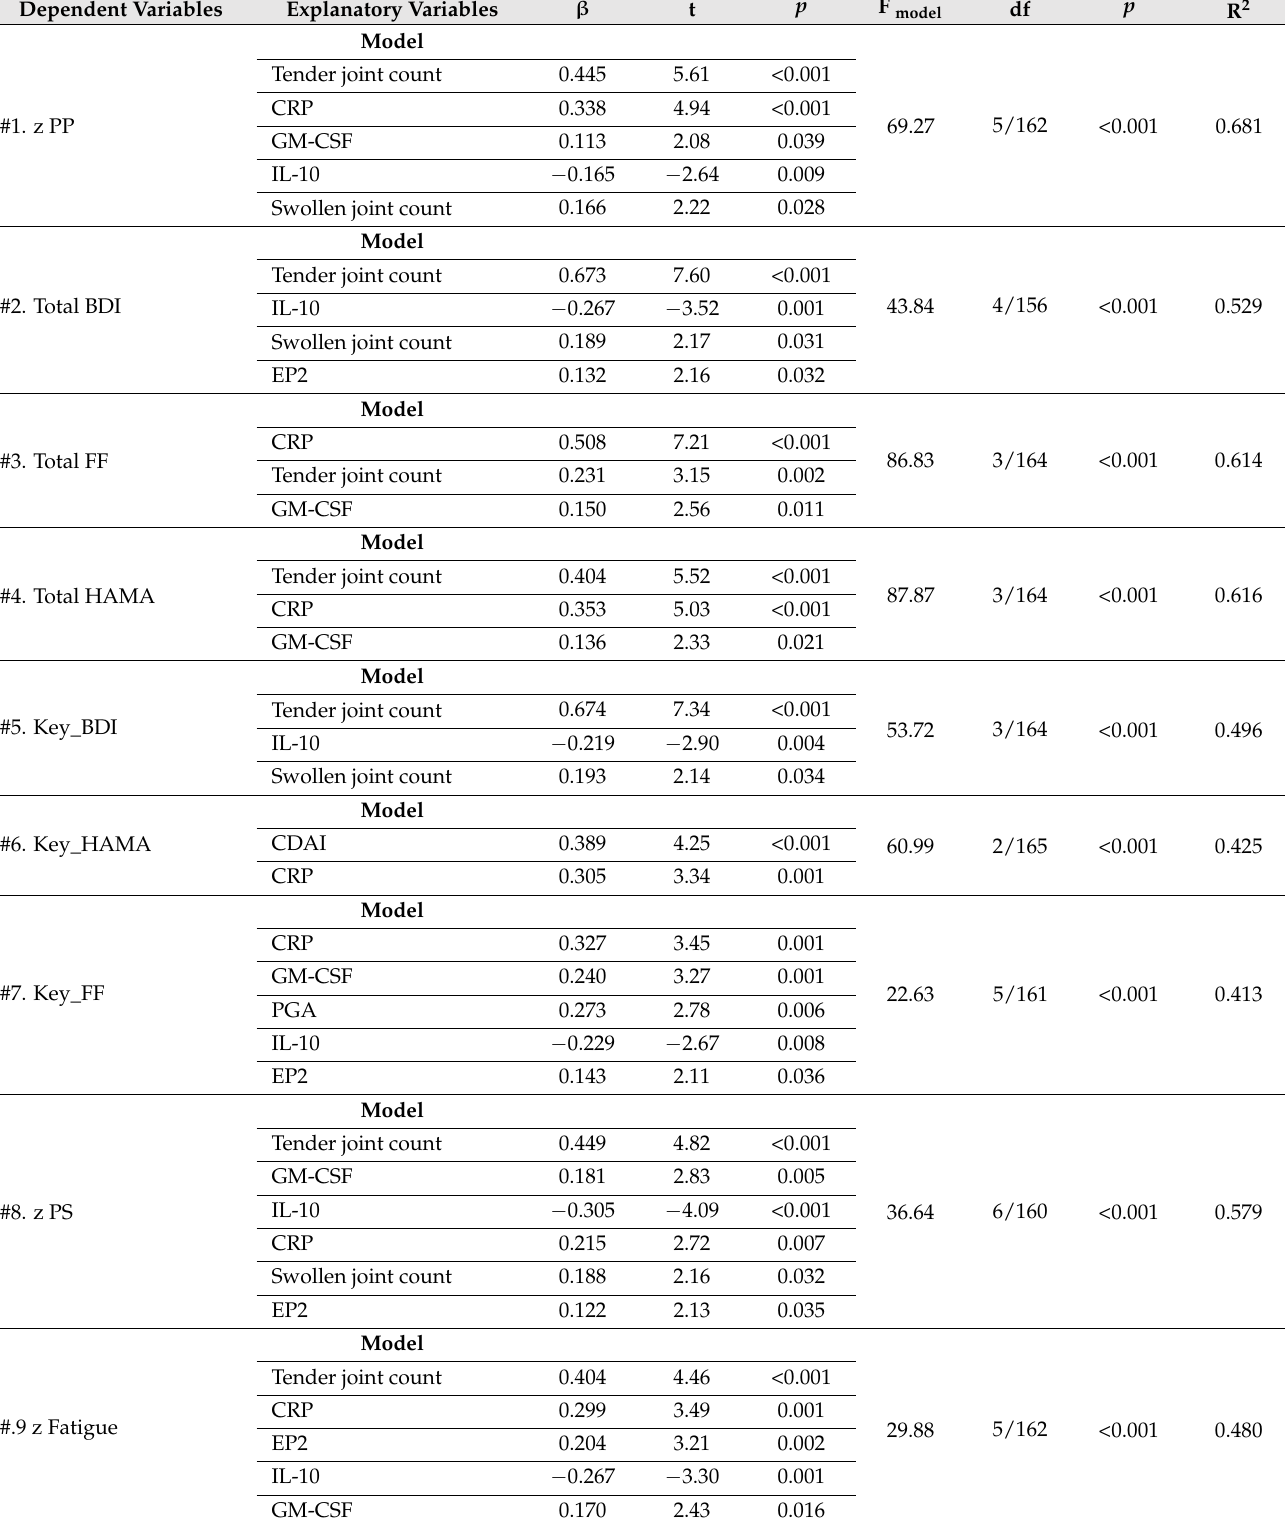
Table 7. Results of multiple regression analysis with psychiatric symptom domains as dependent